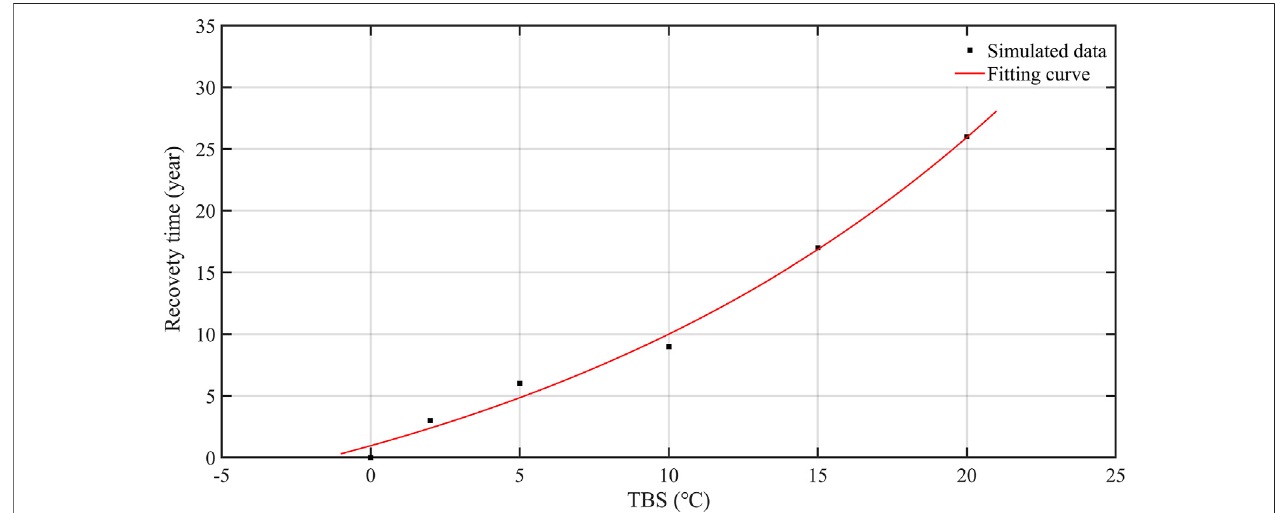
FIGURE 7 | Relationship between temperature of the back fi lling soil (TBS) and the recovery time of ground temperature.